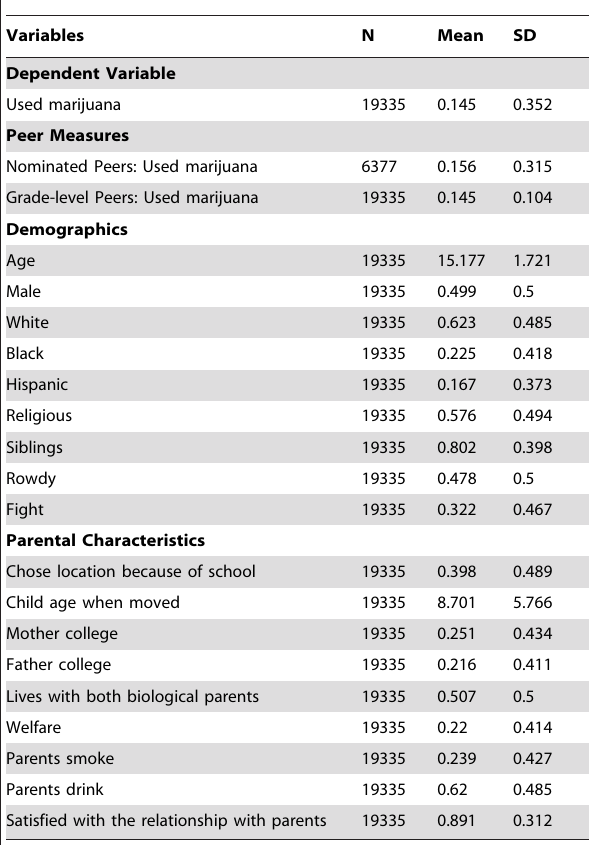
Table 1. Descriptive statistics for wave I